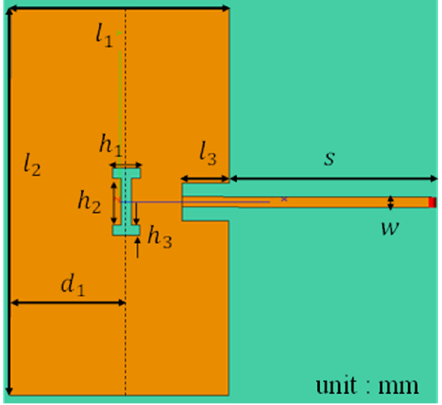
Figure 1. Proposed antenna model and its parameters. Table 1. Material and dimension of the substrate during optimization.